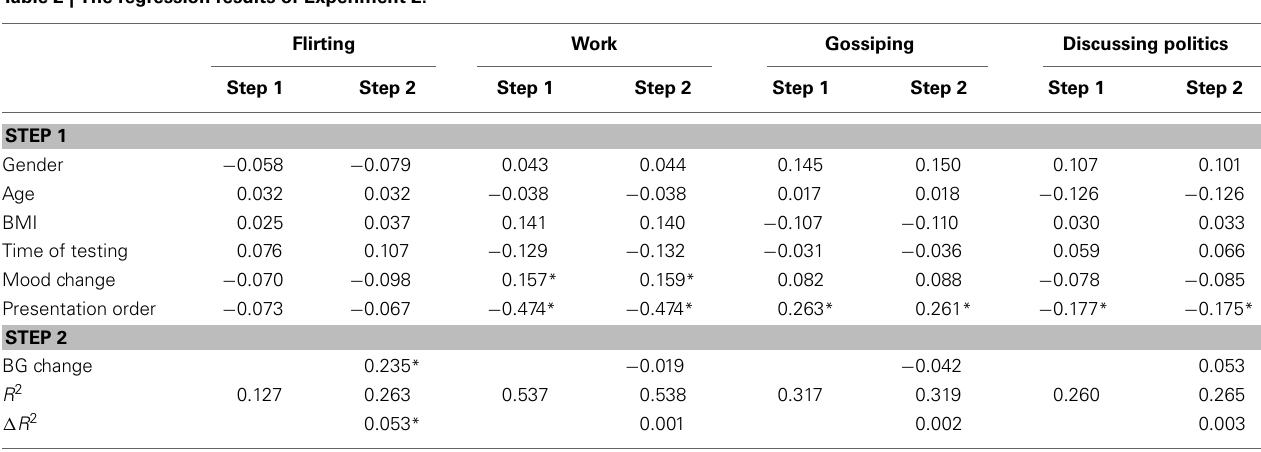
Table 2 | The regression results of Experiment